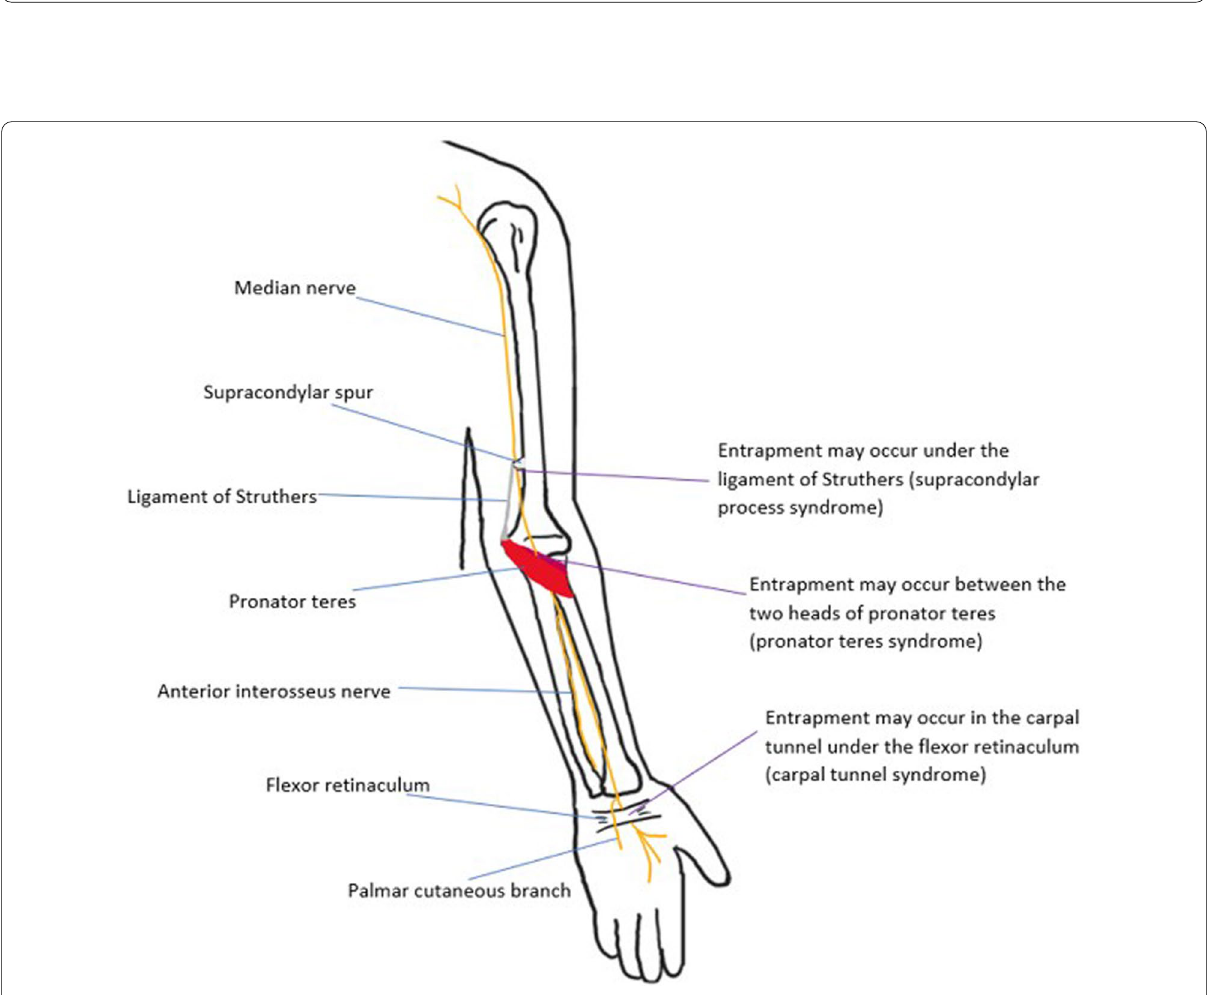
Fig. 10 The median nerve is shown. Entrapment neuropathies of the median nerve include carpal tunnel syndrome, pronator teres syndrome and supracondylar process